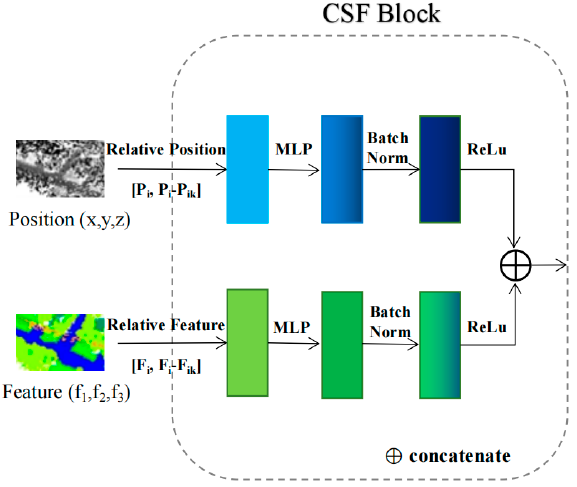
Figure 5. The proposed context semantic fusion (CSF) block to leverage semantic information.